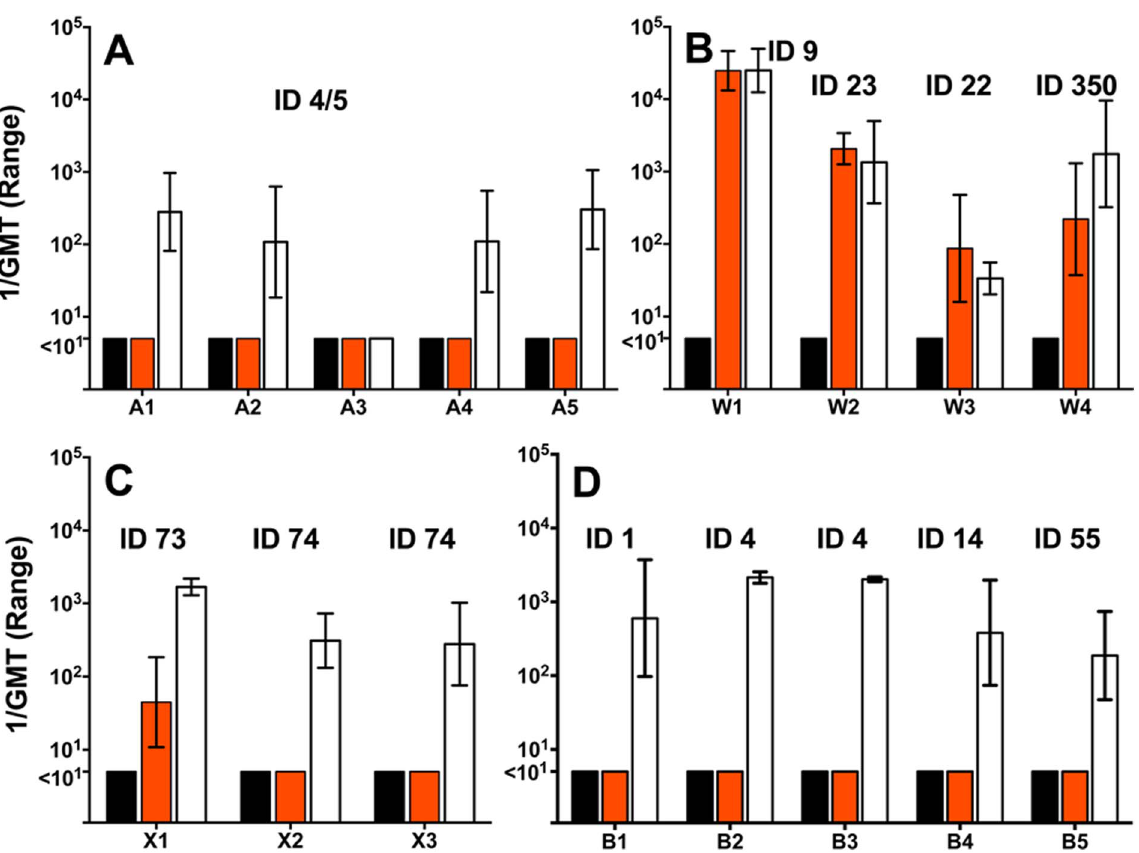
Figure 5. Serum bactericidal antibody responses of mice immunized with NOMV-fHbp vaccine. Panels A, B and C, MenA, W or X isolates, respectively, from cases of disease isolated during epidemics in sub-Saharan Africa. Panel D, MenB isolates from industrialized countries. The MenA, X and B strains had fHbp amino acid sequence variants in variant group 1 (See Table 1). The MenW stains had fHbp in variant group 1 (ID 9, ID 350) or variant group 2 (ID 23, ID 22). Bars represent the reciprocal GMT and ranges of three serum pools per vaccine group, and two pools for the adjuvant alone (four individual sera in each pool). Black bars, control mice immunized with aluminum hydroxide without a vaccine antigen; orange bars, control mice immunized with a NOMV-fHbp KO vaccine; white bars, mice immunized with the NOMV-fHbp vaccine.